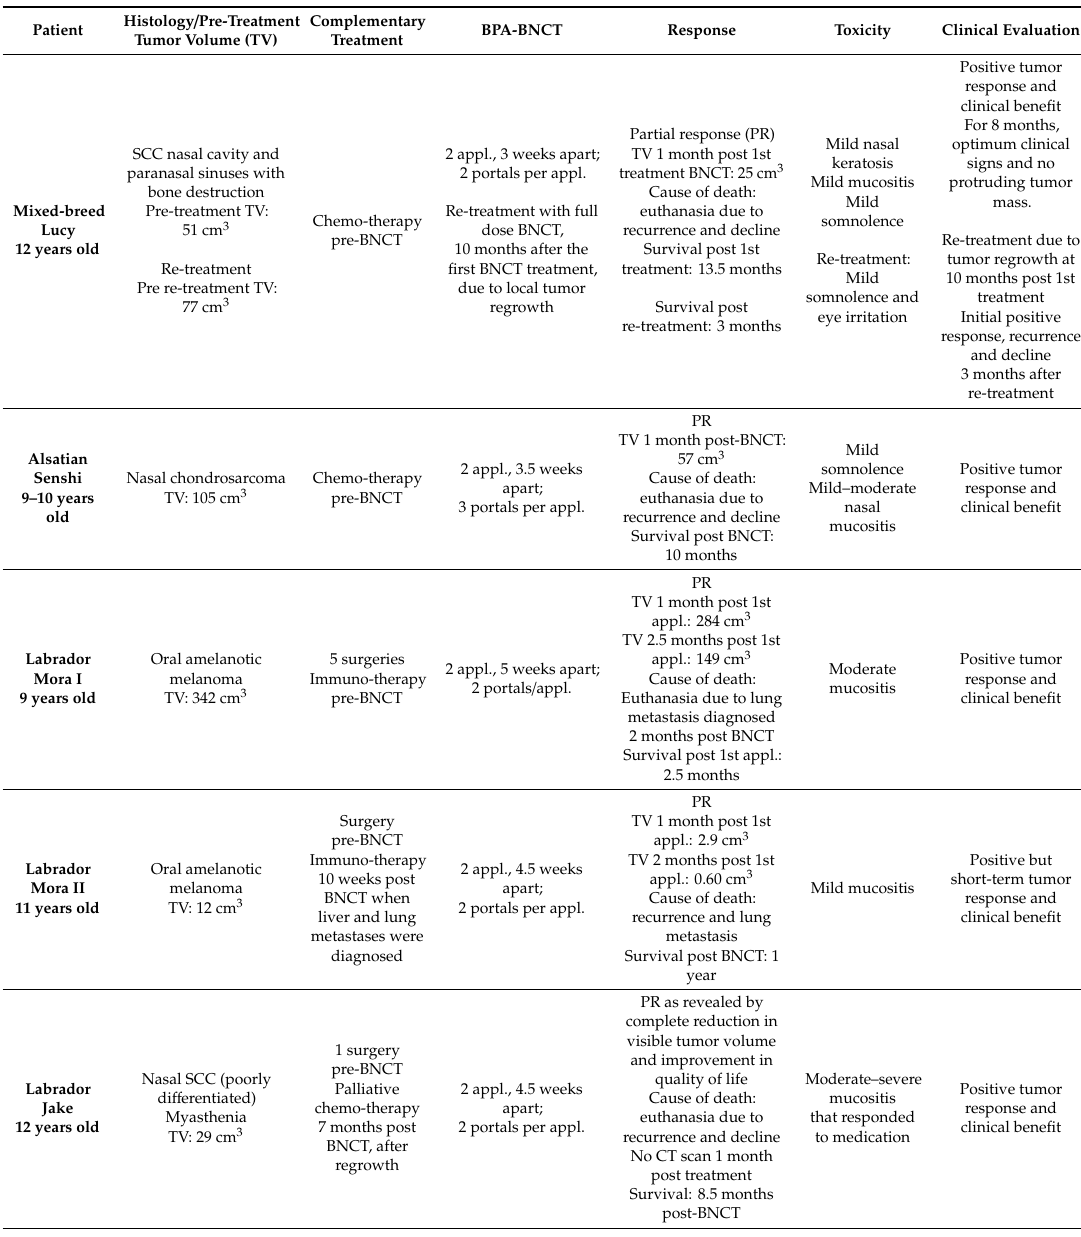
Table 3. Patient details and outcome. SCC: Squamous Cell Carcinoma; BPA-BNCT: BNCT mediated by the boron compound